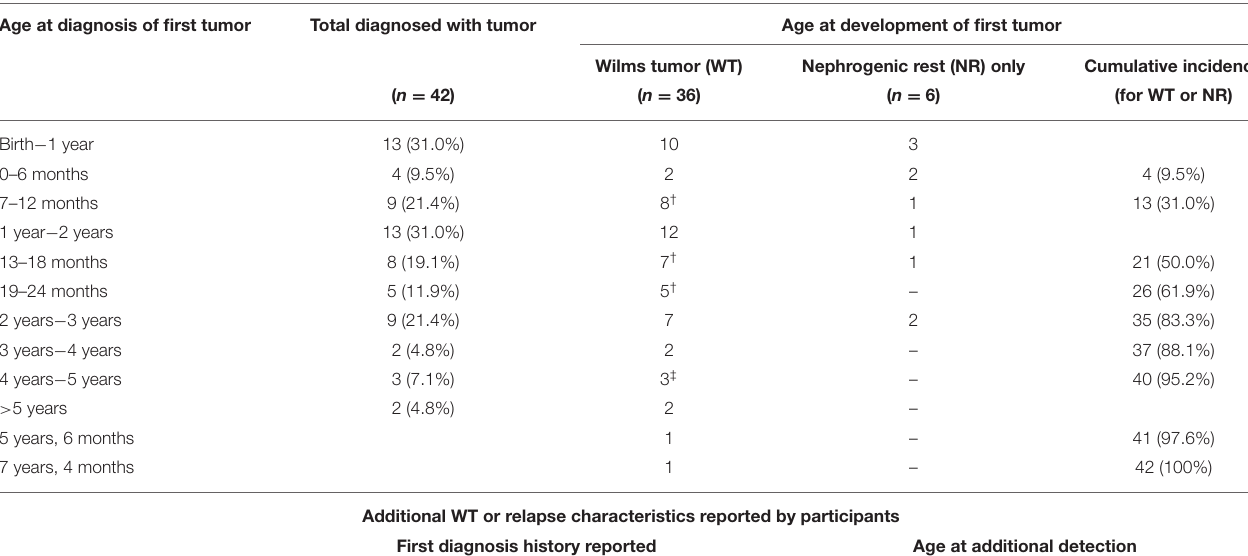
TABLE 2 | Age at first development of Wilms tumor and/or nephrogenic rests in WAGR discovery cohort. Age at diagnosis of first tumor Total diagnosed with tumor Age at development of first